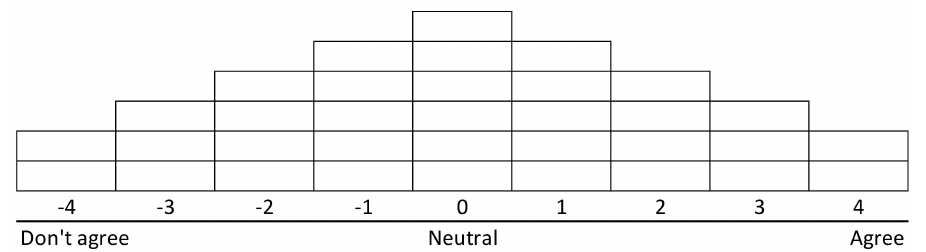
Figure 1. Ranking matrix used for Q